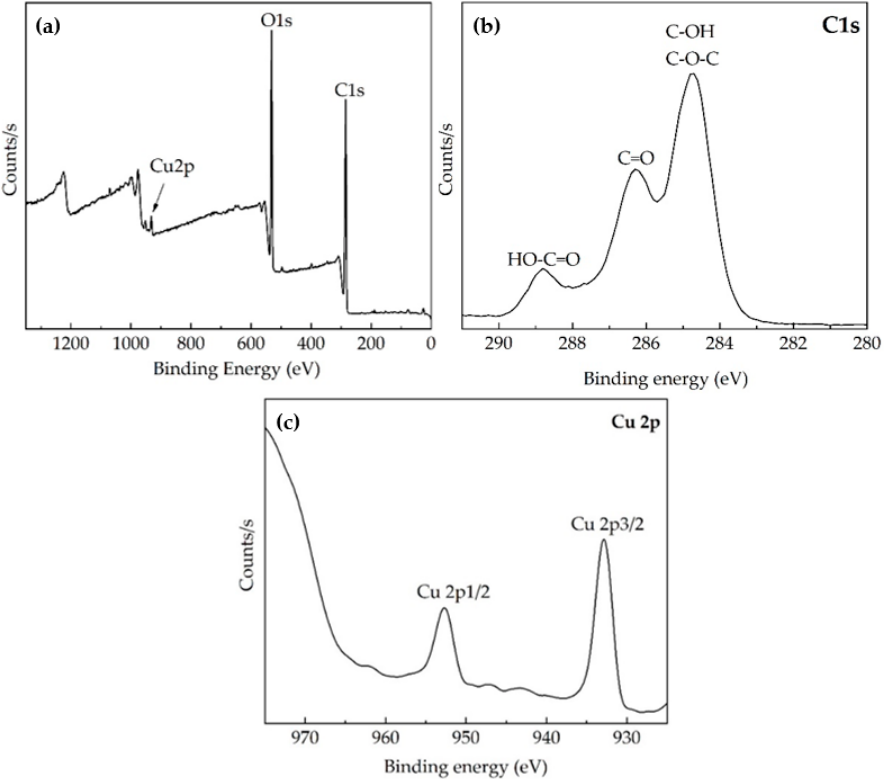
Figure 3. XPS spectra of PES/CO fabric functionalized with copper oxides ( a ); high-resolution for Cs ( b ) and Cu 2p ( c ).